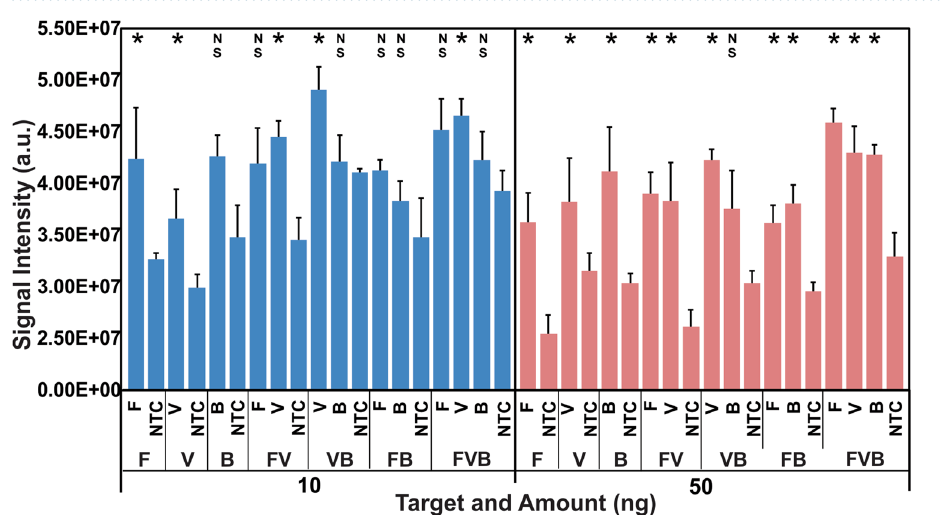
Figure 4. Detection limit (DL) analysis of the functionalized filter paper based on PCR products amplified from genomic DNA. F, V, or B represents a single PCR product. FV, VB, or FB is the corresponding duplex PCR product. FVB means the triplex PCR product. The signal intensities of blue columns represent detection outcome when 10 ng of each target was used, and the pink ones represent the results when 50 ng of each target was used. Every signal intensity was compared to that of NTC on the same paper slide. The work was done in triplicate. The DL was between 0.1 ng/µL and 0.5 ng/µL. F: Saccharomyces cerevisiae . V: human cytomegalovirus. B: Escherichia coli . NTC: negative control. * p ≤ 0.05 using student t-test (F, V, and B) or p ≤ 0.05/comparison times using post hoc test (FV, VB, FB, or FVB). NS: no significant